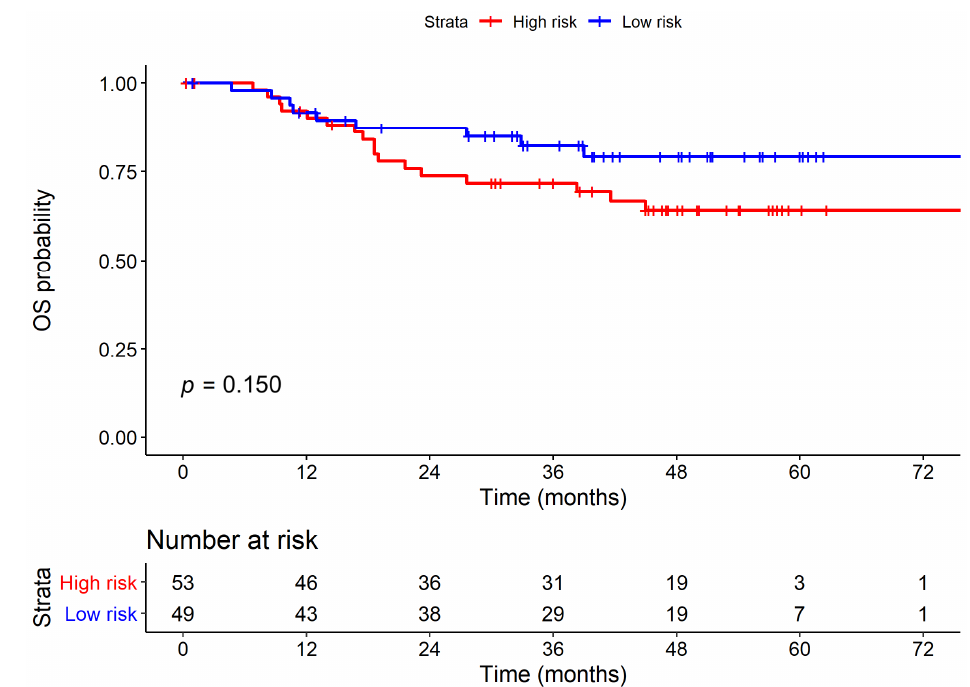
Figure 4. Kaplan–Meier plot of overall survival (OS) stratified by 8th protein staining cluster.